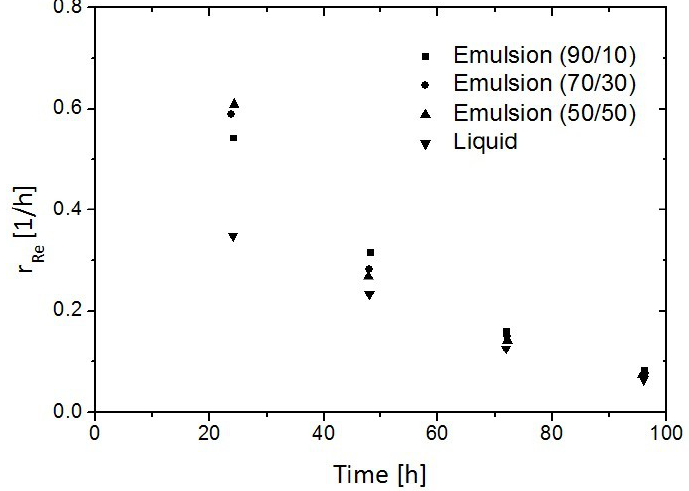
with different forms of CO 4